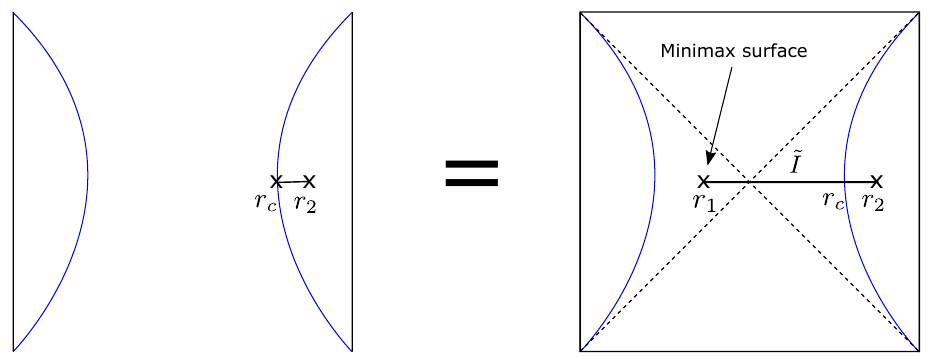
Figure 3 . The fine-grained entropy for regions specified in the exact quantum-mechanical de- scription (left side of equality) would equal the generalized entropy for the regions specified in the semiclassical spacetime (right side of equality) if the minimax surface shown was an acceptable quantum extremal